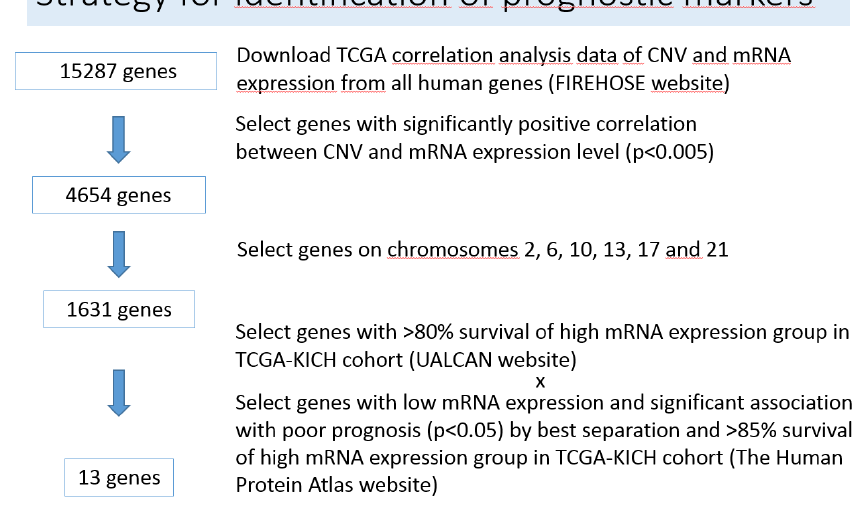
Figure 2. Strategy for identification of prognostic markers. Table 1. Genes with a highly significant correlation between CNV and mRNA expression level, cellular localization of their proteins and their function.